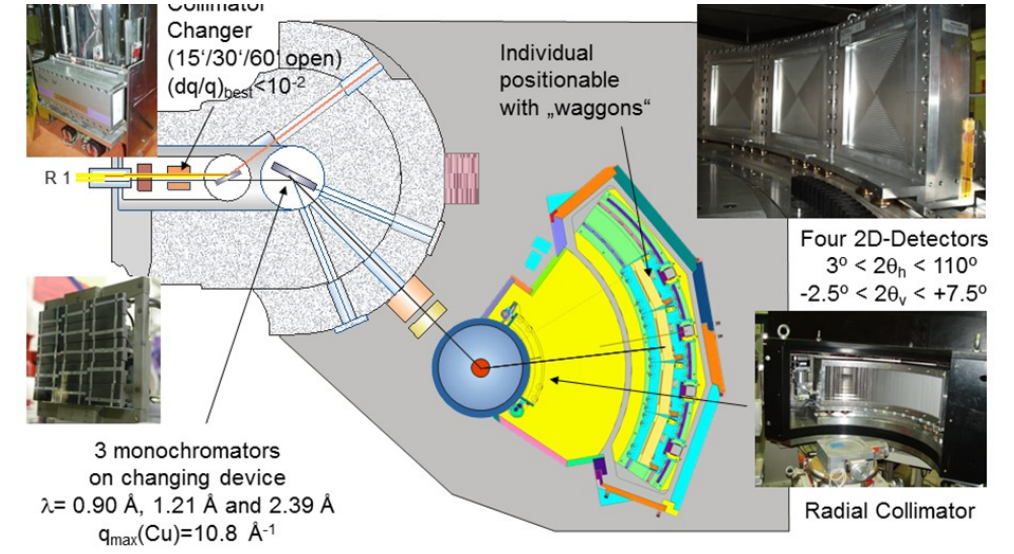
Figure 2: Schematic sketch of